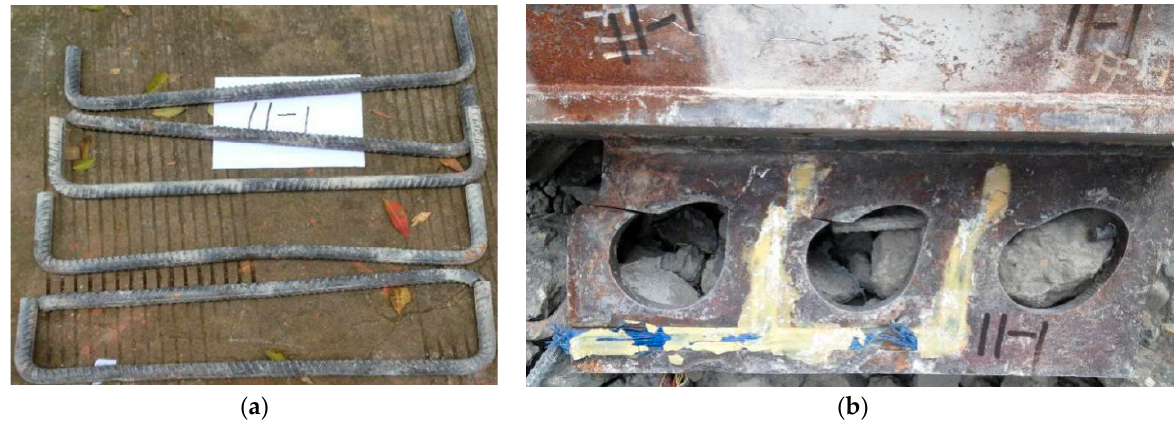
Figure 20. Rib plate failures of the BH-11 specimen after test: ( a ) Deformation form of reinforcement; ( b ) Deformation form of rib Figure 4. 3. Rib Thickness.